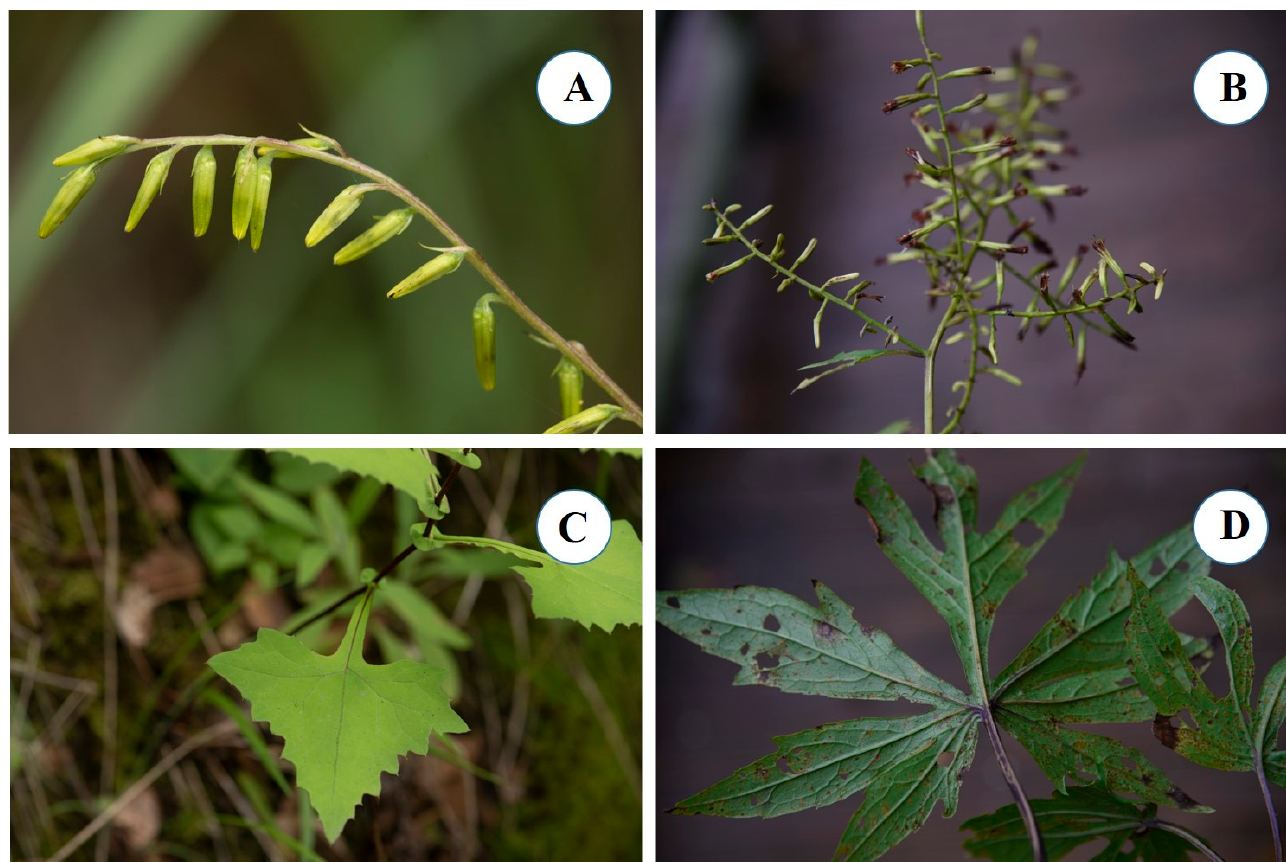
Figure 1. Images of Parasenecio latipes and P. palmatisectus . ( A , B ) Inflorescence of plant growing in natural habitat; ( C , D ) morphology of leaf. (( A , C ) P. latipes , voucher FZX5888, SCNU, Muli county, Sichuan province, China). (( B , D ) P. palmatisectus , voucher DY122, SCNU, Guangwu mountain, Bazhong city, Sichuan province, China). Photographs by Zhixi Fu.